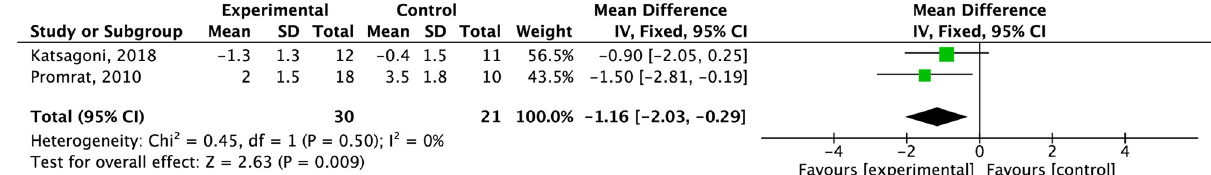
Fig 6. Effect of exercise plus diet compared to the control group in intrahepatic lipids assessed by NAS score.